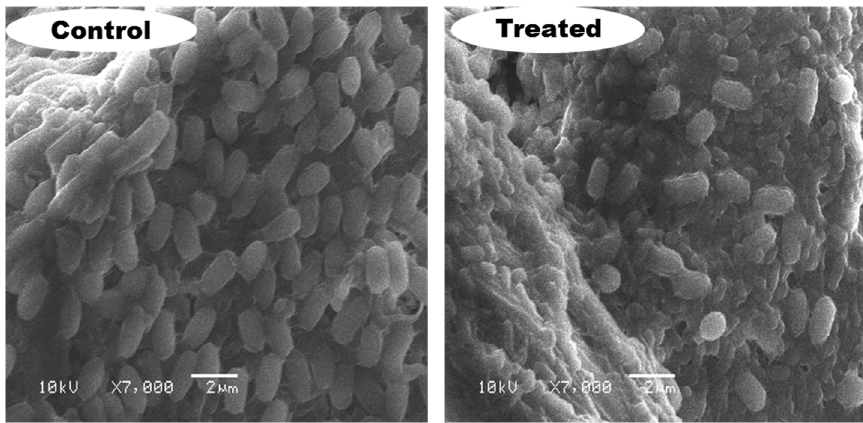
Figure 7. SEM analysis of treated K. pneumonia with EtOAc extract at 80 µg. 3.5. Antiproliferative Activity of the EtoAc Extract of ess_amH1 The cytotoxicity of the EtoAc extract of ess_amH1 against MCF-7 (breast cancer) and Hep-G2 (hepatocarcinoma cells) cells increased dose-dependently (Figure 8). The measured IC 50 concentration was 50 µ g/mL and 75 µ g/mL against MCF-7 and Hep-G2 cell lines, respectively. This shows that breast cancer cells are likely to be sensitive toward the treatment of EtoAc extract of ess_amH1 strain. The means ± SE followed by different letters (a–e) within the same row indicate a significant difference (Tukey’s test, p < 0.05). In comparison to the cytotoxicity activity of doxorubicin against MCF-7 and Hep-G2 cells (42 and 77.2%, respectively) at 100 µ g/mL, ess_amH1 extract had strong anticancer activity at 100 µ g/mL.